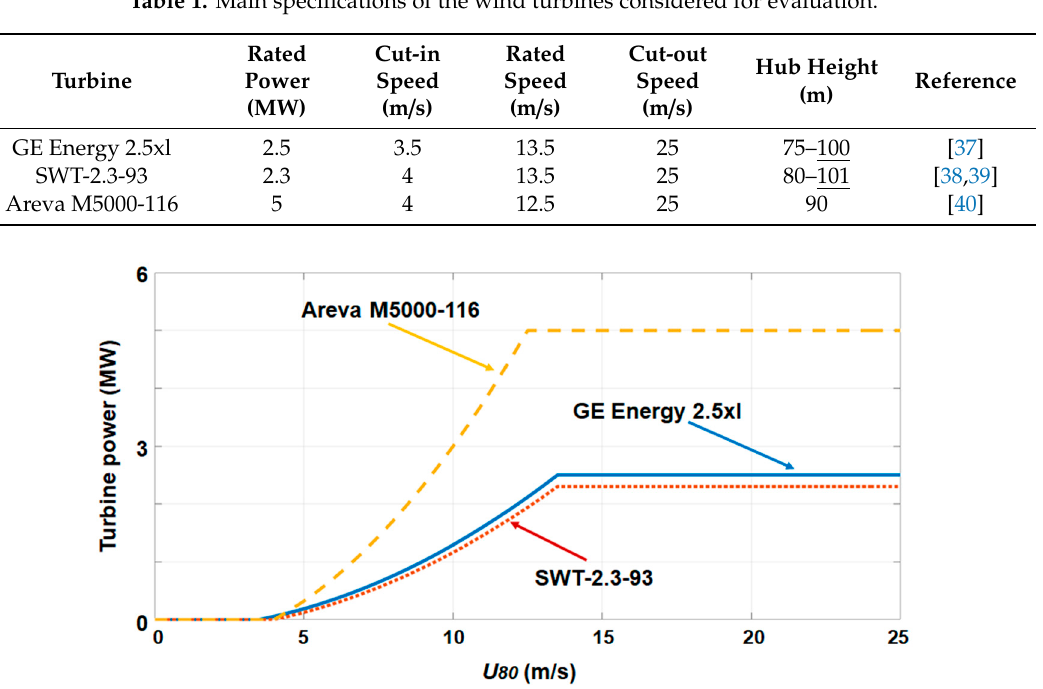
Figure 3. Power curves of the GE Energy 2.5xl, SWT-2.3-93 and Areva M5000-116 wind turbines considered for evaluation.